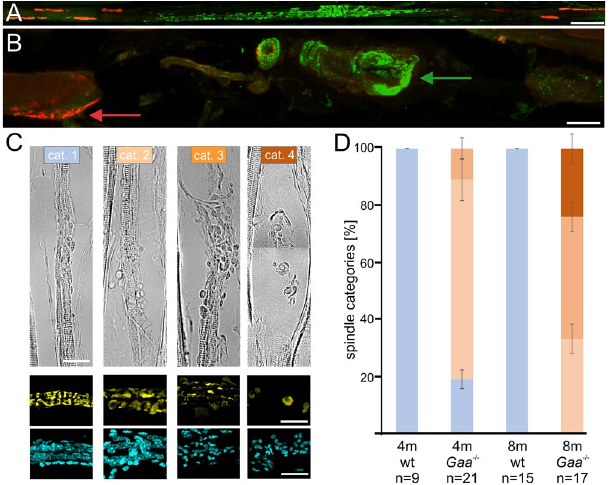
Figure 4. Quantification of the degenerative changes in muscle spindles from Gaa −/− mice. Intrafusal fibers are innervated by sensory nerve terminals in the central (equatorial) region (stained with antibodies against vGluT1; green channel in ( A,B )) and by γ-motoneurons in the polar regions, which form a cholinergic synapse (indicated by α-bungarotoxin labeling of the AChRs; red channel in ( A,B )). Note the normal structure of the intrafusal fiber innervation in muscle spindles from 8-month-old 129/SvJ mice ( A ) and the severely degenerated innervation in the 8-month-old Gaa −/− mice (( B ); corresponding to a category 4 muscle spindle, see below). The sensory nerve terminal has retracted from the intrafusal fiber and has formed a large varicosity (green arrow). AChRs have disaggregated (red arrow) and the intrafusal fiber has lost its elongated shape and formed a spherical myoball-like structure. Panel ( C ) shows representative examples of the four different categories used to characterize the different levels of degeneration. For a more detailed description of the categories, see “Methods” section. The lower two rows of panel ( C ) show representative examples corresponding to the different categories of the morphology of the sensory ending (green channel) and the distribution of the nuclei (blue channel), respectively. Morphological analysis of 4- and 8-month-old muscle spindles from wildtype (wt) and Gaa −/− mice revealed a progressive increase of the number of damaged muscle spindles demonstrating the progressive degenerative changes (panel ( D )). Bars show the mean ± SD with N = 3; n represents the number of muscle spindles analyzed. Color-coding of the different categories is identical in panels ( C,D ). Scale bar: ( A ) 50 µm, ( B ) 20 µm, ( C ) 20